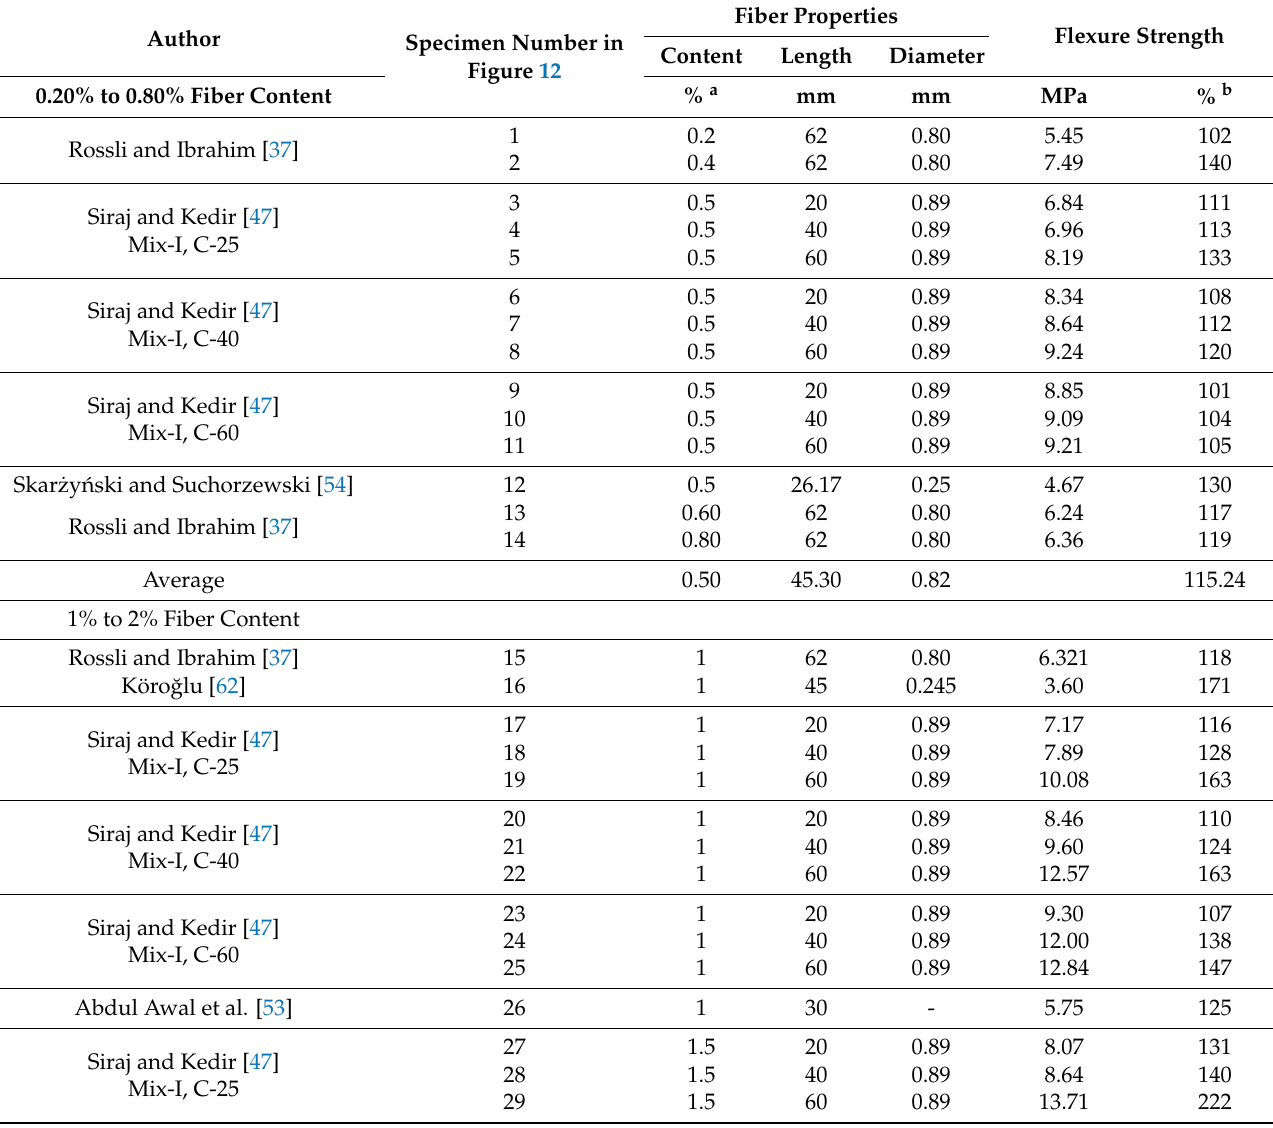
Table 9. Results of flexure strength’s percent comparison and fiber properties of the concrete incorpo- rating RSF by its volume